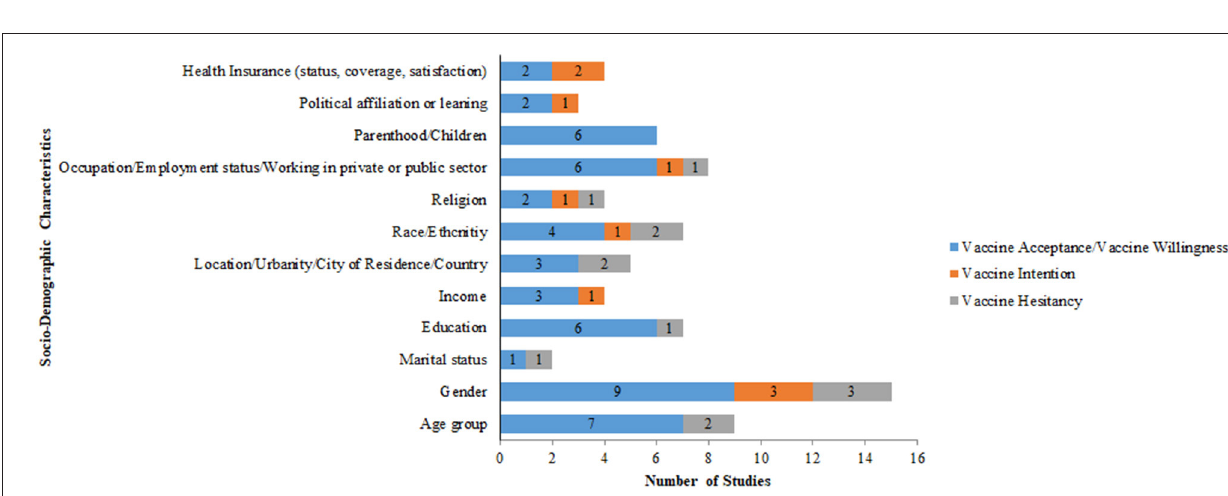
gender, older adults, higher educational attainment, and higher levels of perceived likelihood to get a COVID-19 infection in the future, perceived severity of COVID-19 infection, vaccine history, and efficacy of the vaccine. Some of the associations leading to lower vaccine acceptance/willingness in the United States rushed vaccine development, Black